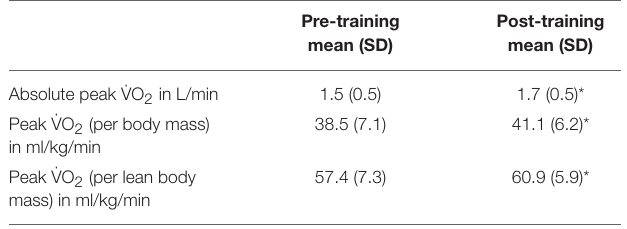
TABLE 2 | Aerobic fitness before and after